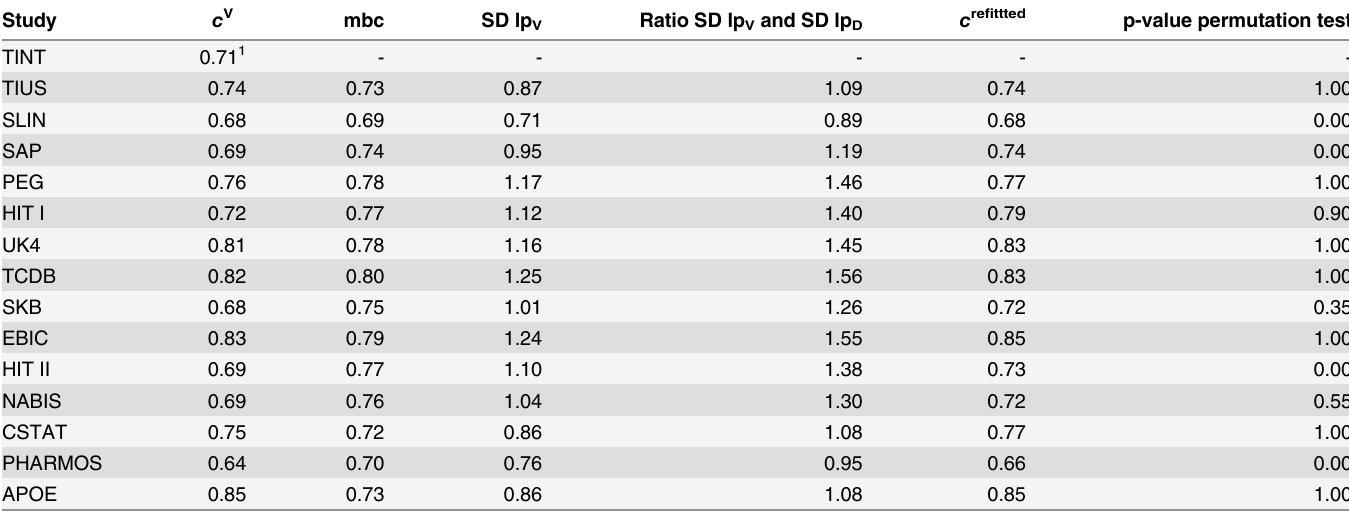
Table 3. External validation results of the model predicting 6-month mortality in TBI patients using age, motor score and pupillary reactivity. Study